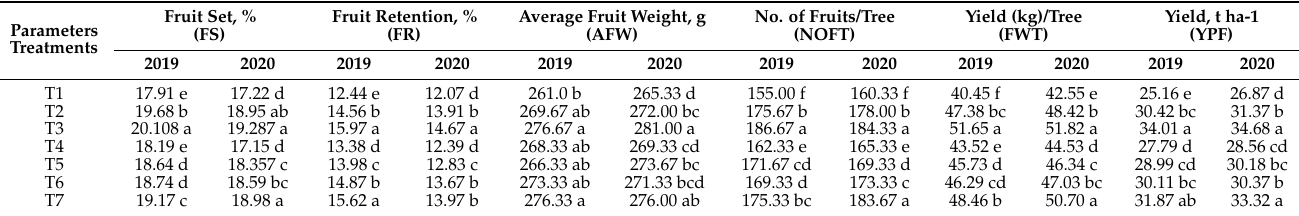
Table 5. Influence of iron (nano, sulfate, and chelated) foliar spray on some fruiting aspects of Washington navel orange trees during 2019 and 2020 experimental seasons.